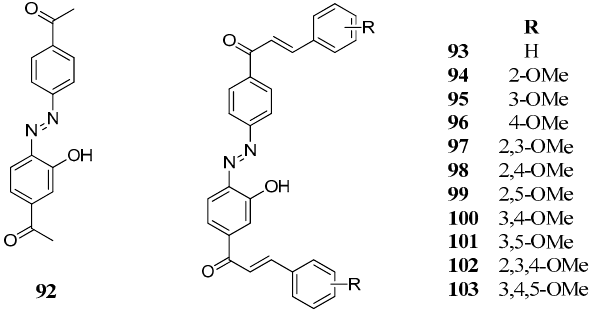
Figure 20. Structures of compounds 92 – 103 . Table 11. K I values of the compounds 92 – 103 (CA esterase activity).